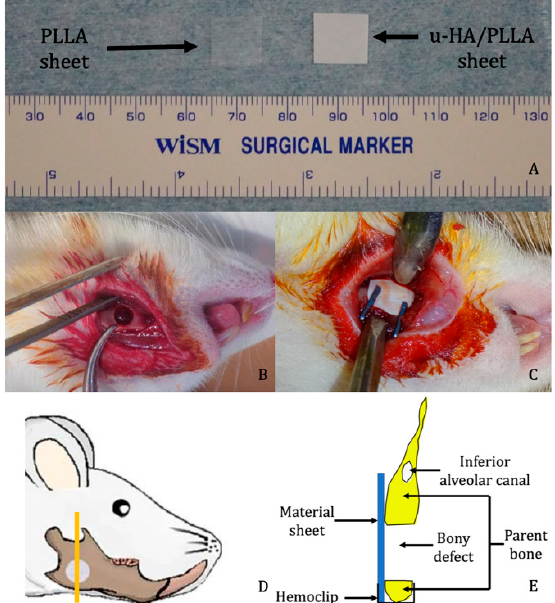
Figure 1. Surgical procedure. ( A ) Examples of unsintered hydroxyapatite/poly L -lactide (u-HA/PLLA) and PLLA sheets. ( B ) Critical size defect created at the mandibular angle. ( C ) Placement of reconstructive material. ( D ) Site from which the sample was taken for analysis (the image was modified from Sha et al. [19]). ( E ) Schematic coronal view of the specimen.